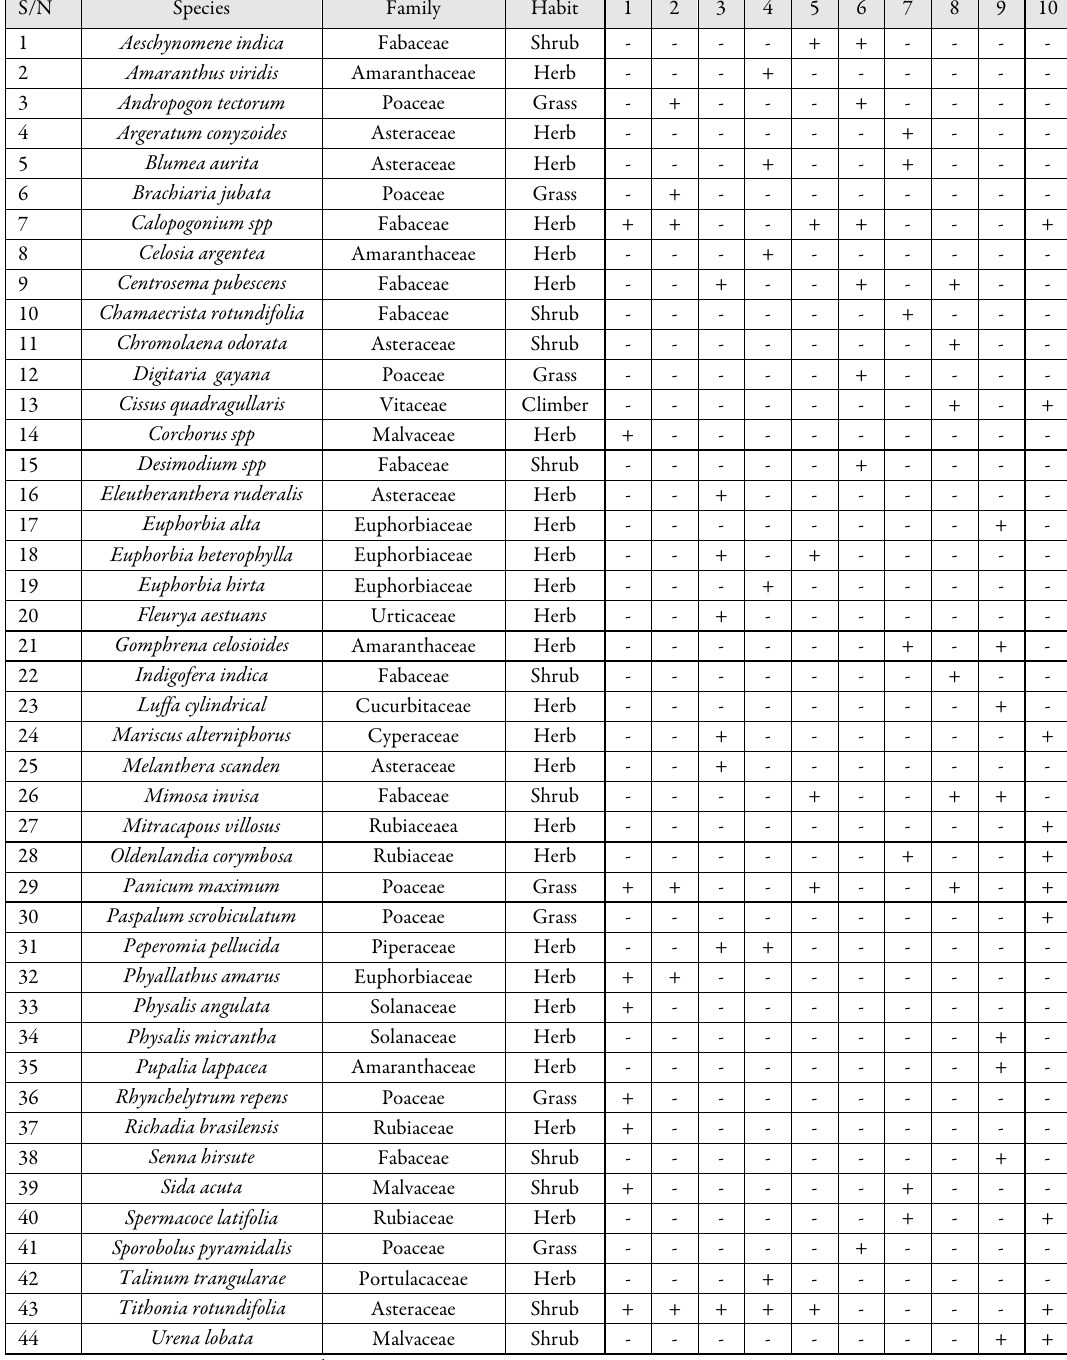
Table 1. Plant species composition on the standing vegetation of the study